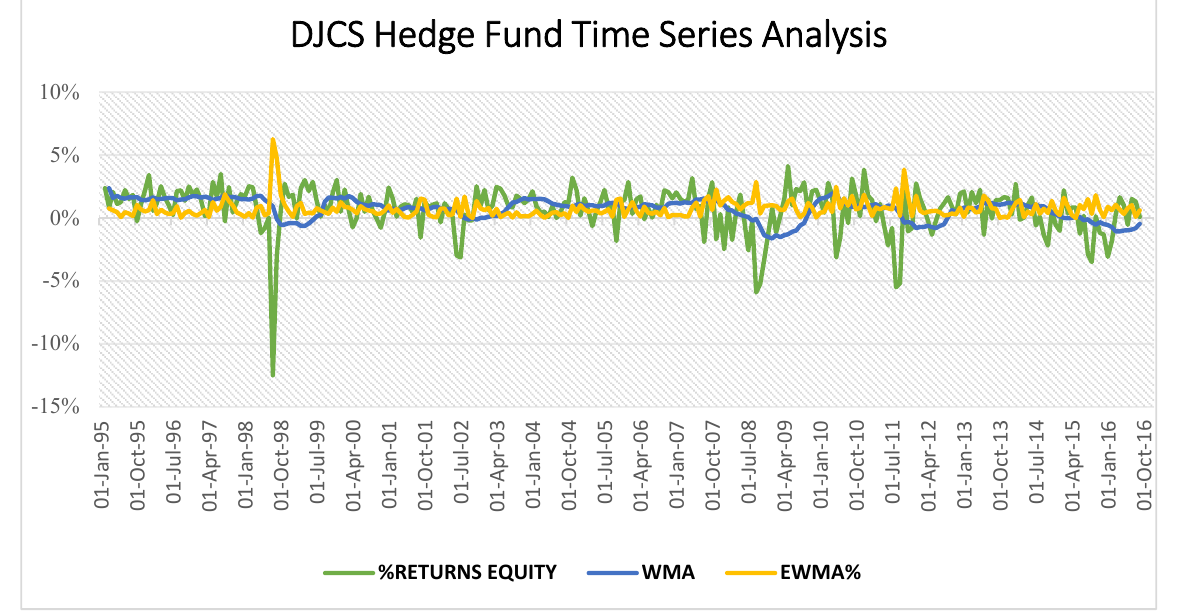
Figure 10. DJCS monthly time series analysis, hedge fund. Source: authors.